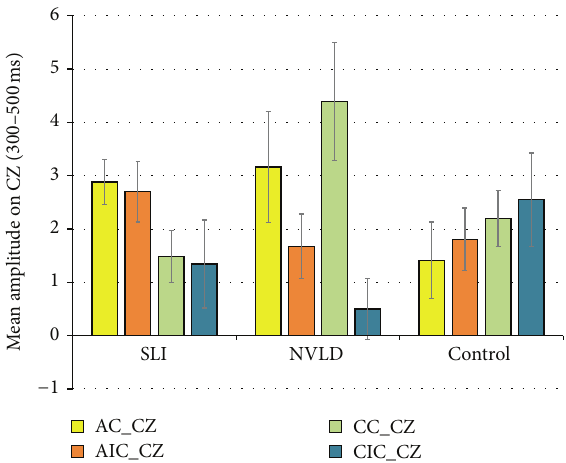
Figure 13: Mean amplitudes of ERP responses in the four condi- tions, for the three groups, on central sites (300–500 ms period), summarizing concreteness (AIC versus CIC), congruency (CC versus CIC), and figurativity (AC versus AIC) effects. AC: abstract- congruent; AIC: abstract-incongruent; CC: concrete-congruent; CIC: concrete-incongruent. Error bars represent standard